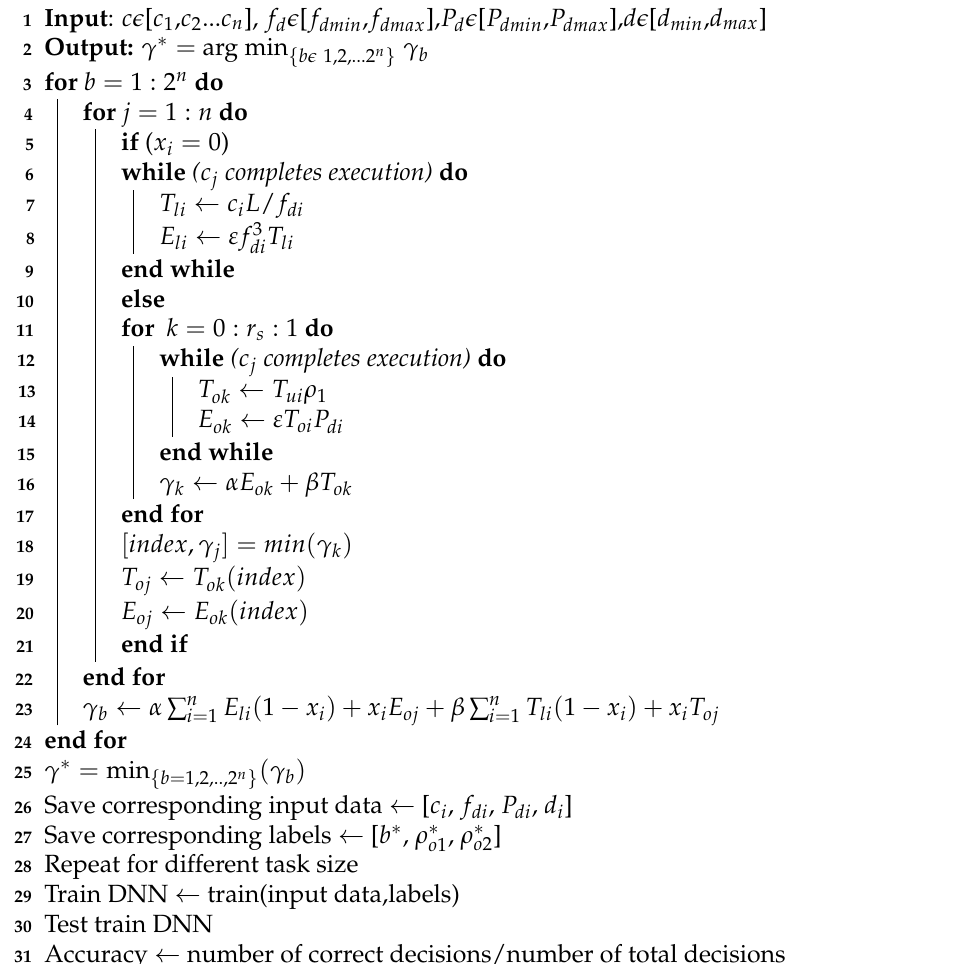
Algorithm 1: Joint Time Allocation and Offload